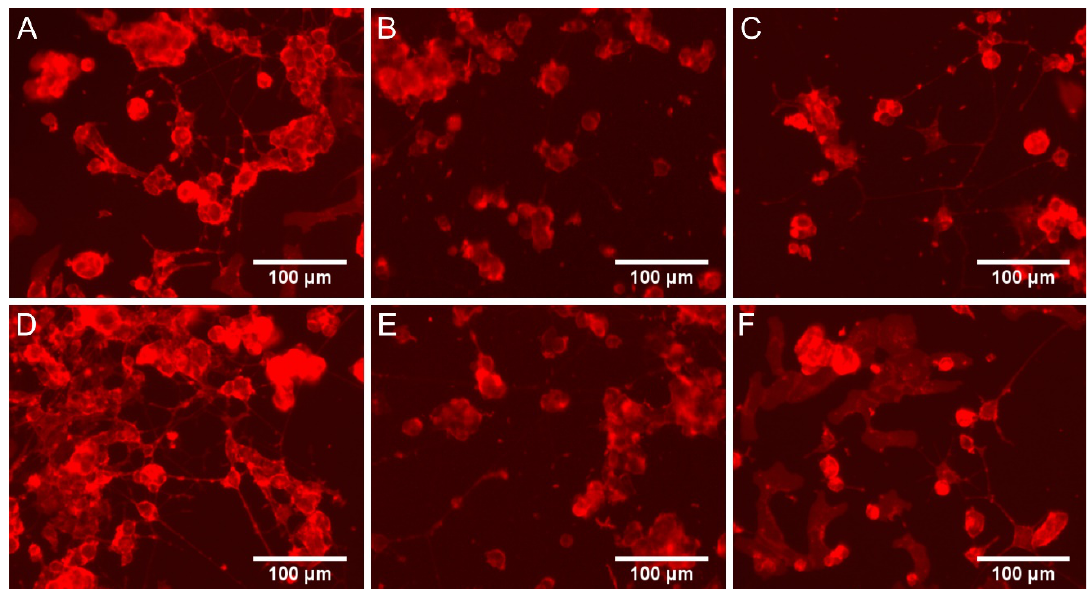
Figure 5. Sample microphotographs of cell cultures stained with “Neurite Outgrowth Staining Kit”: ( A ) negative control without LPS; ( B ) control with LPS; ( C ) LPS and compound 2a (50 µ M); ( D ) LPS and compound 2b (50 µ M); ( E ) LPS and compound 3a (50 µ M); ( F ) LPS and compound 3b (50 µ M). Table 1. Pearson correlation coefficients between the mitochondrial activity and the average length of neurites or neurite outgrowth measured spectrofluorimetrically. Length of neurites Neurite outgrowth vs. vs. Compound mitochondrial activity mitochondrial activity 2a 0.864 0.993 2b 0.768 0.741 3a 0.987 0.769 3b 0.991 0.741